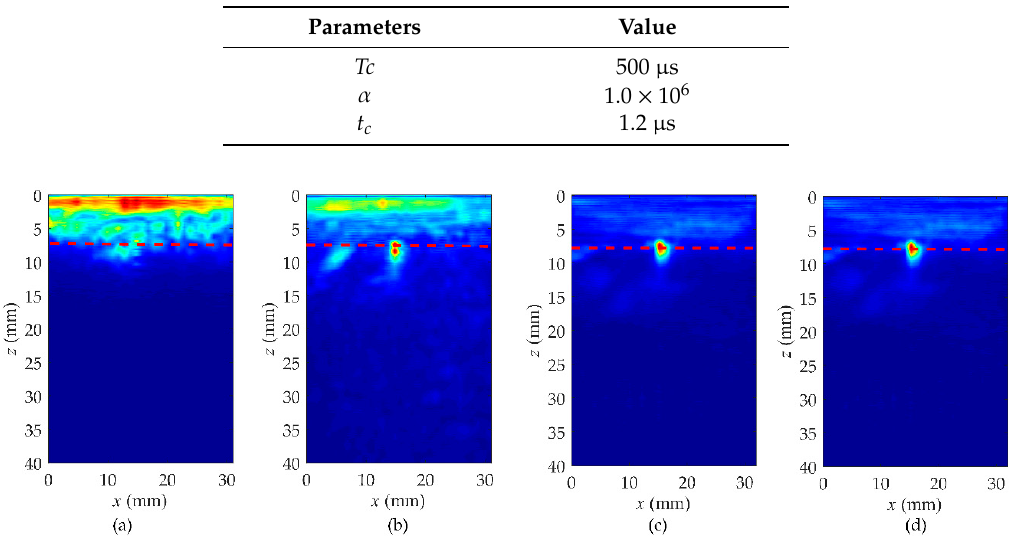
Table 3. The parameters of the hybrid full matrix, f i , j ( t ) .